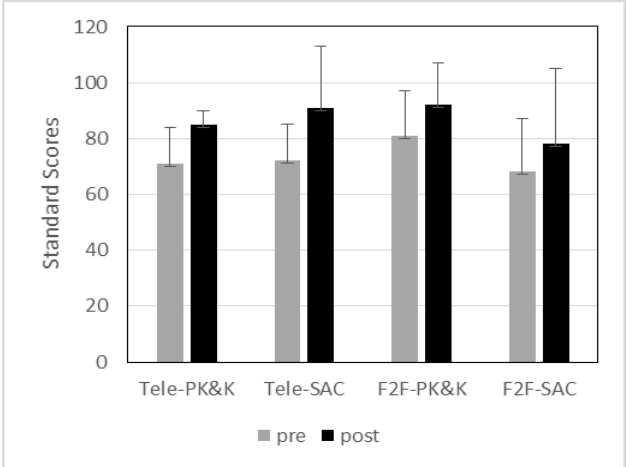
Figure 2. Means and standard deviations of phonological awareness skills between pre- and post-tests between telepractice (experimental) and in-person (control) group.